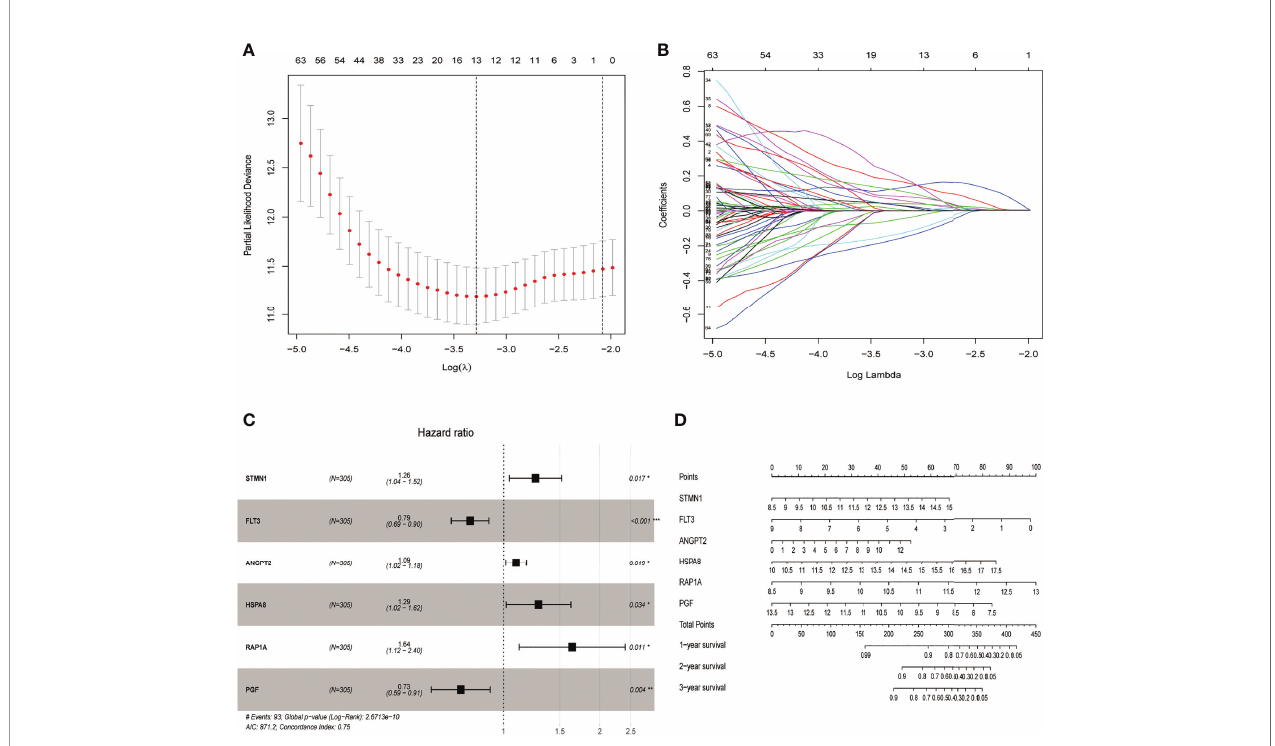
FIGURE 2 | Screening out genes for constructing a risk signature. (A) Log (Lambda) value of the 11 genes in LASSO model. (B) The most proper log (Lambda) value in LASSO model. (C) Six genes (STMN1, FLT3, ANGPT2, HSPA8, RAP1A, and PGF) were selected for constructing a risk signature using multivariate Cox regression model. (D) A nomogram for predicting 1-, 3- and 5-year survival rate of HCC patients was established. * p < 0.05; ** p < 0.01; *** p <